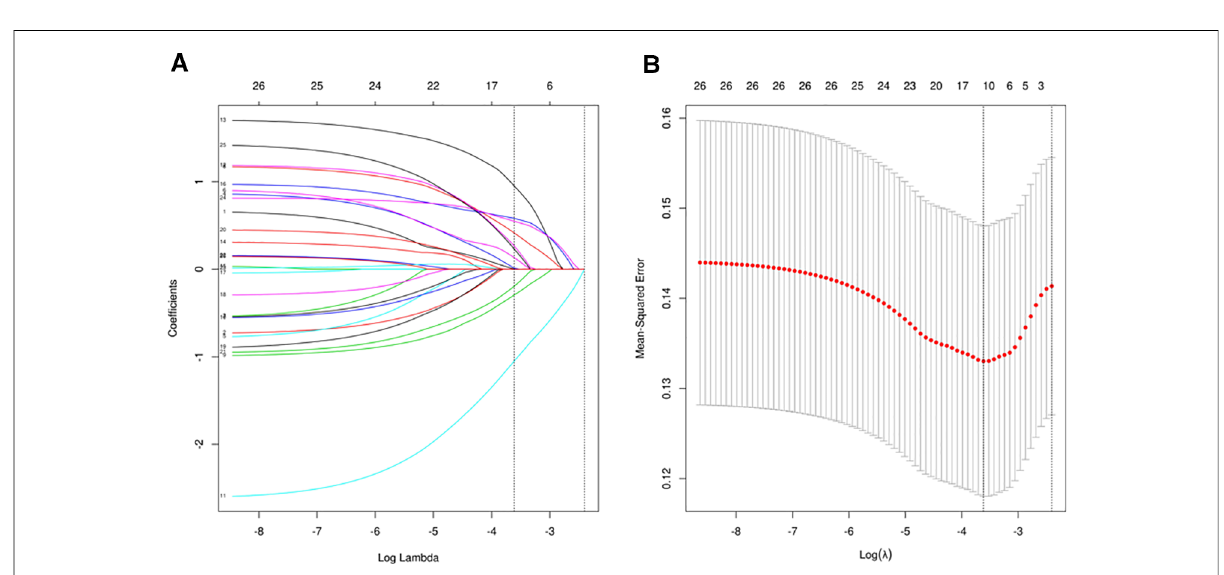
FIGURE 2 ( A ) The regression analysis of in fl uence factors based on Lasso analysis for variable selection; ( B ) the cross-validation of the regression